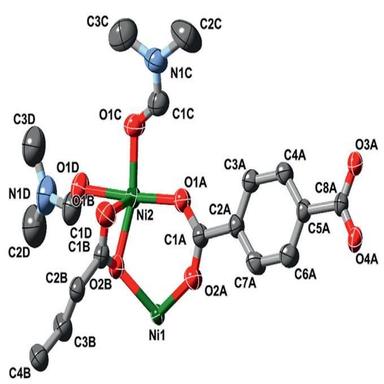
The asymmetric unit of Ni3(C8H4O4)3(C3H7NO)4.